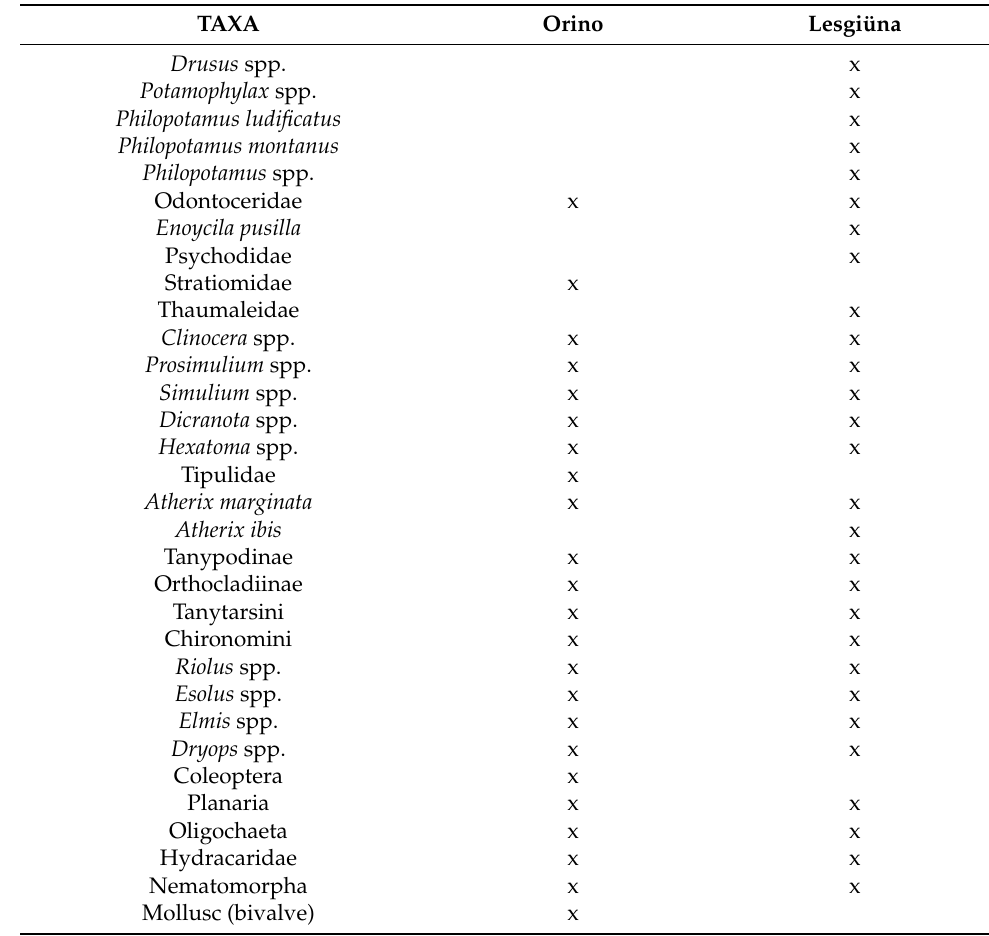
Table A3. Cont. TAXA